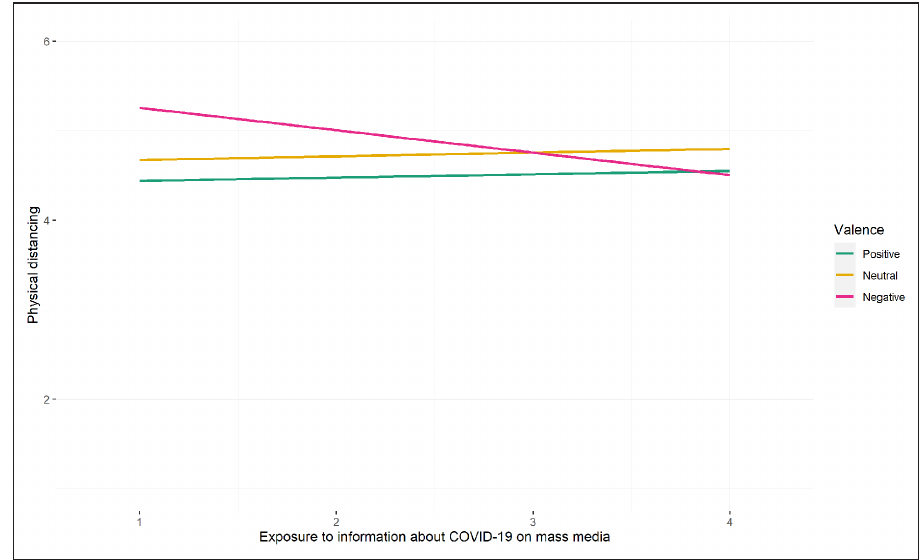
Figure 1 Simple Slopes of the Interaction Between Mass Media and Mass Media Valence on Physical Distancing in the University